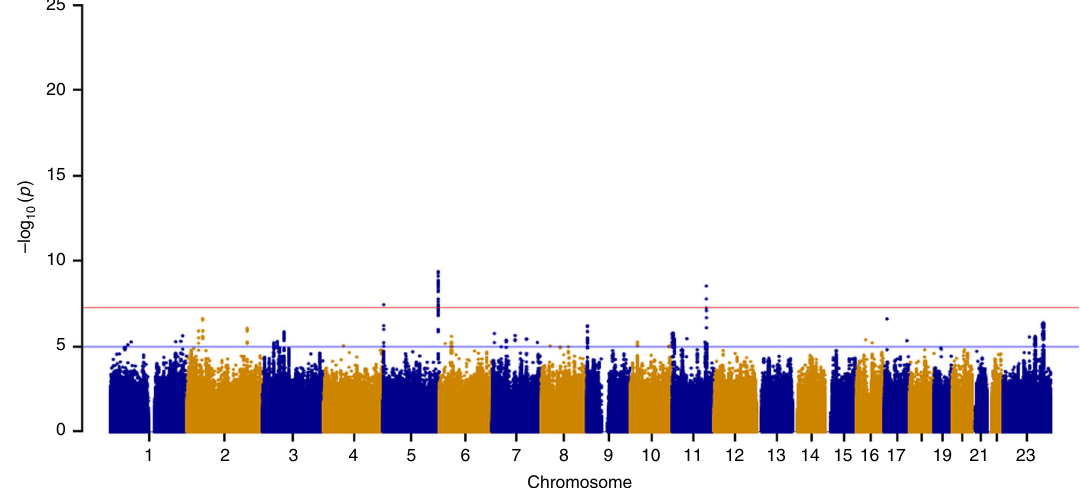
Fig. 3 Manhattan plot for GWAS on UL limited by heavy menstrual bleeding. GWAS across 202,580 women of white European ancestry identi fi ed three independent loci associated with UL limited by heavy menstrual bleeding. Red and blue horizontal lines indicate genome-wide signi fi cant ( P < 5 × 10 − 8 ) and suggestive ( P < 1 × 10 − 5 ) thresholds,